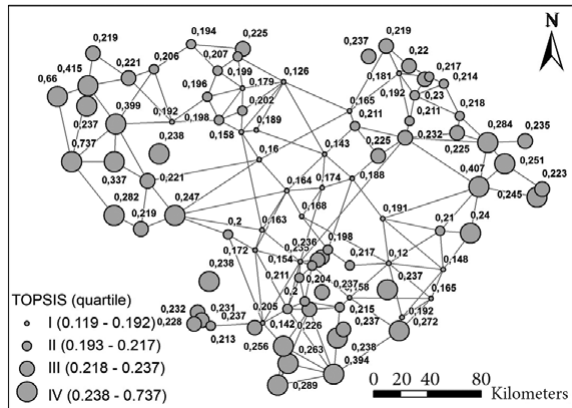
Fig. 5. TOPSIS based ranking of core areas within ecological network